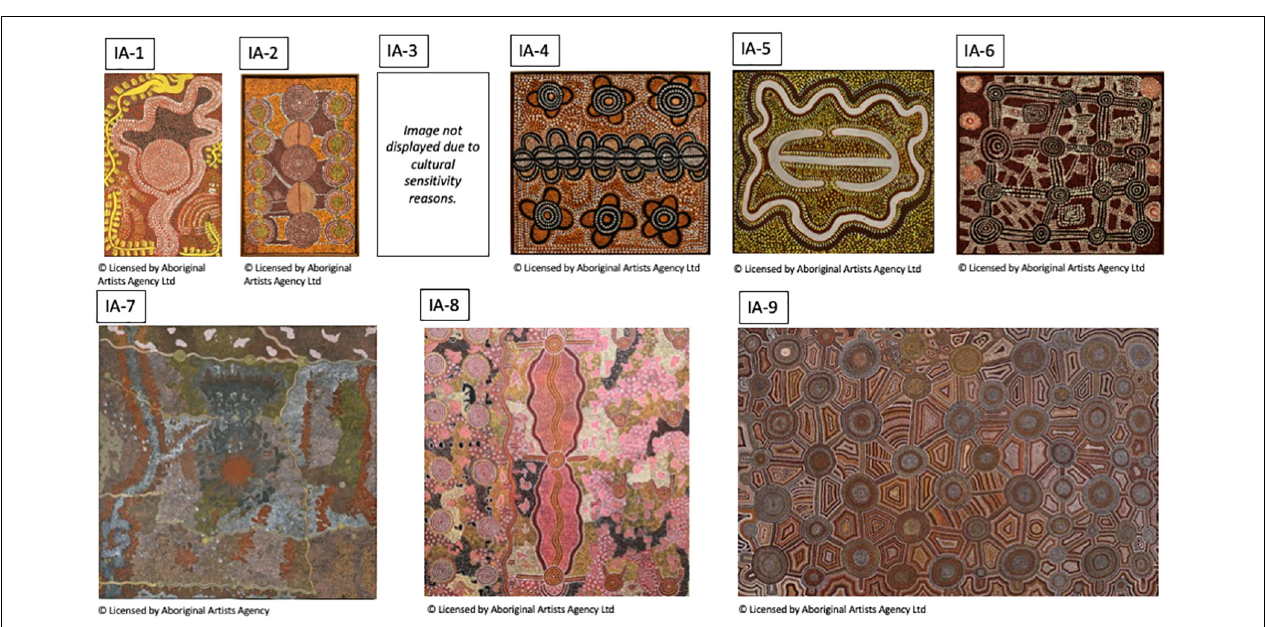
FIGURE 2 | Indigenous Australian paintings used in this study. For detailed description of artworks, see Table 2